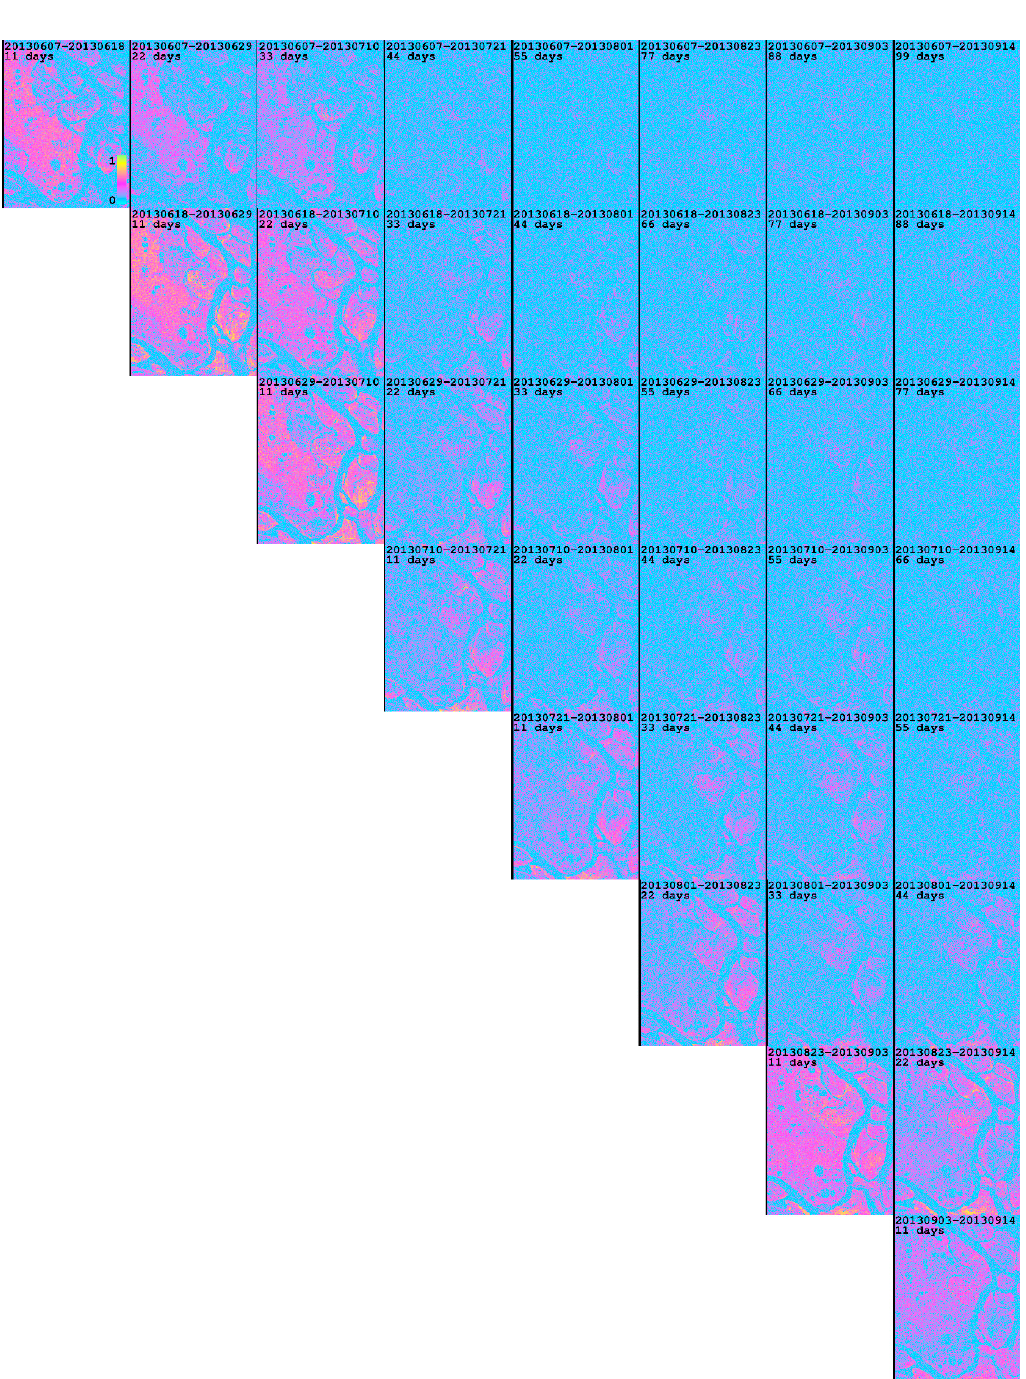
Figure A1. All combinations of coherence maps for the area of interest for the period of June–September 2013. On the diagonal, there are interferometric pairs with the minimum time span.